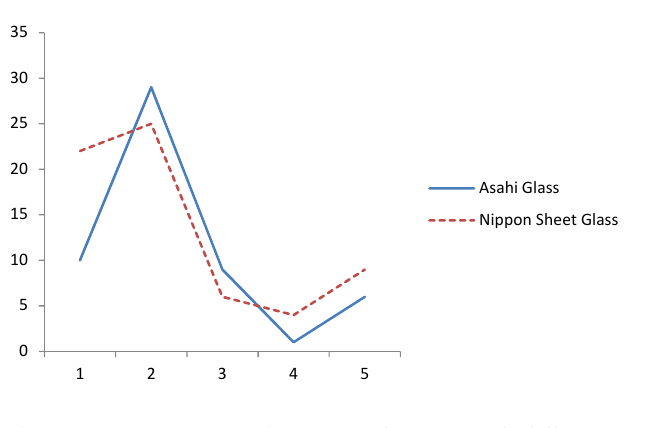
Figure 4. Patent applications during and